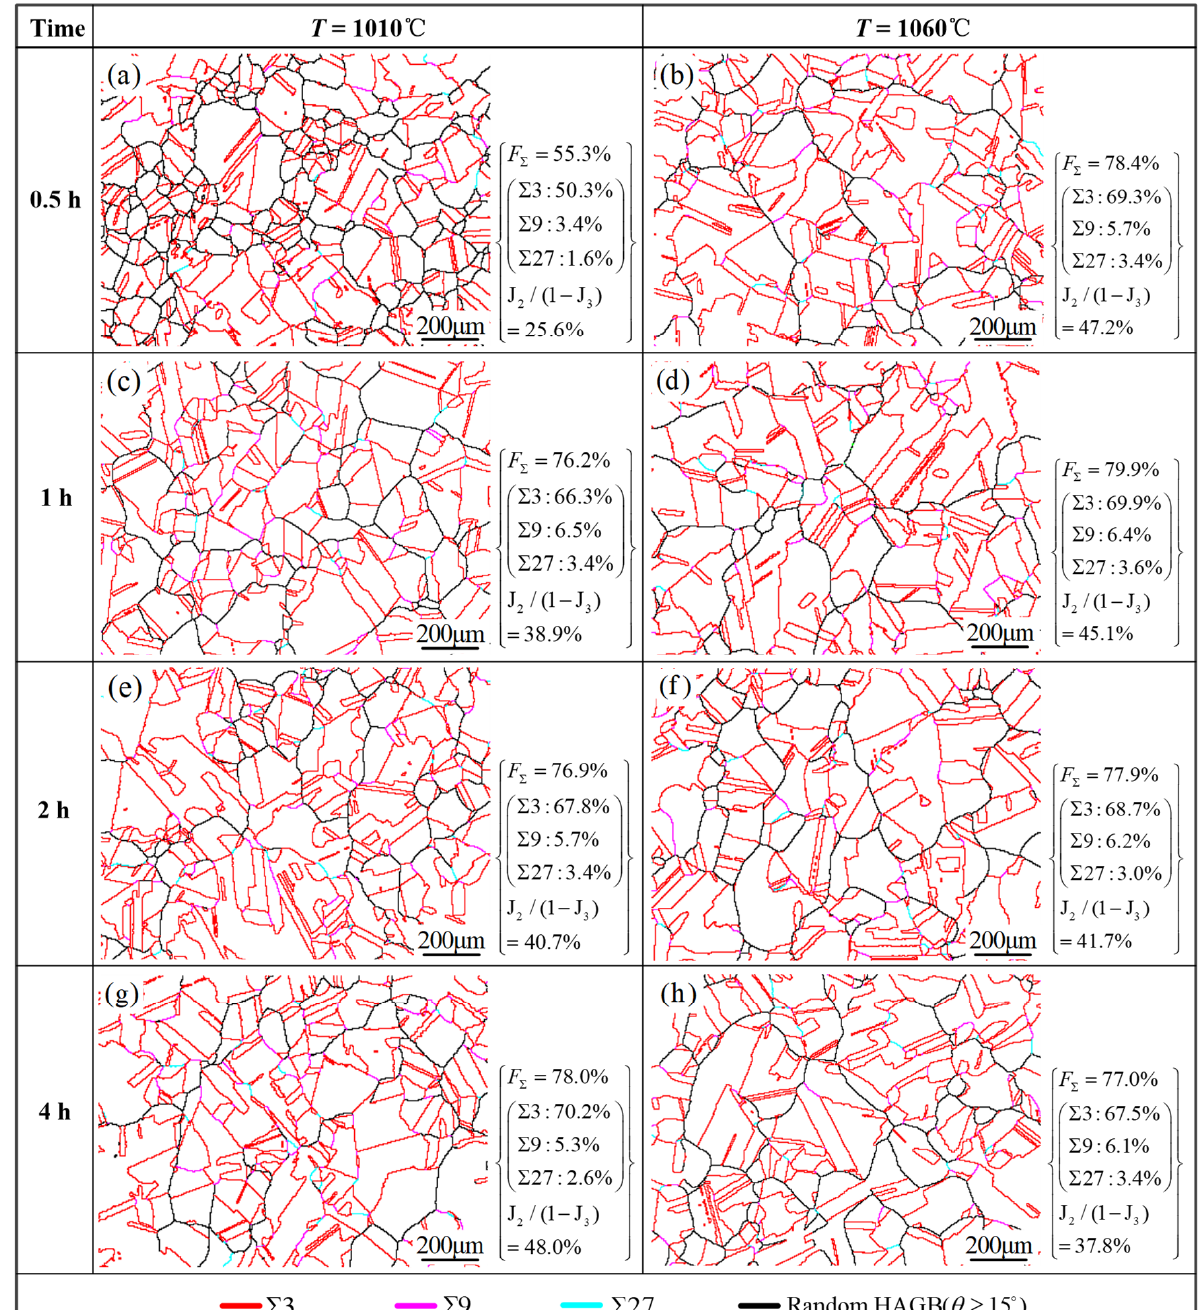
Figure 2. GB distribution maps of specimens annealed at 1010 °C and 1060 °C for different time based on the initial plate after hot-rolling at 800 °C with 5% reduction. ( a , c , e , g ) 1010 °C vs. 0.5 h, 1 h, 2 h, 4 h; ( b , d , f , h ) 1060 °C vs. 0.5 h, 1 h, 2 h, 4 h.